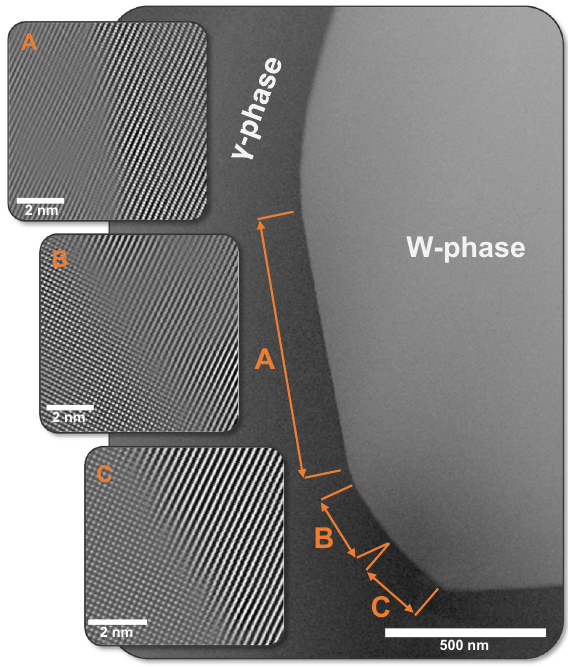
Figure 2. Atomic column micrograph of a multi-faceted region in the rolled WHA. The low magnification region presents facets A, B, and C with the insets to the left exhibiting FFT filtered atomic column micrographs of each facet at or near the on-edge condition. Raw data for each facet FFT micrograph has been provided in the Supplementary